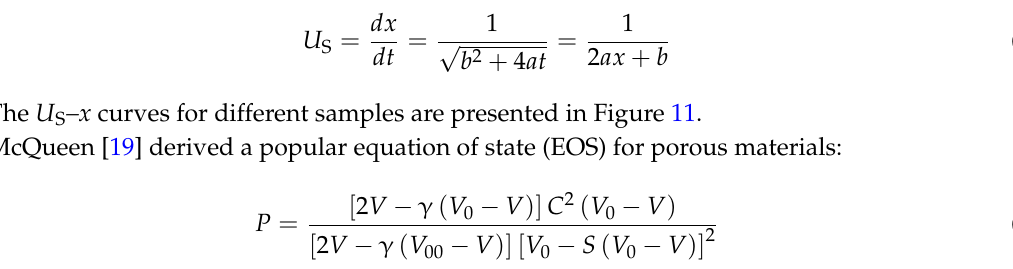
Table 3. Fitting coefficients of different experimental samples.